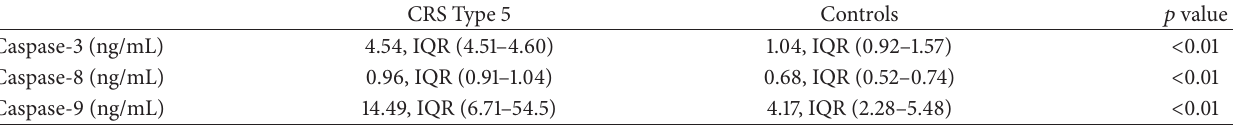
Table 2: Evaluation of caspase-3, caspase-8, and caspase-9 in RTCs after incubation with CRS Type 5 plasma and controls.